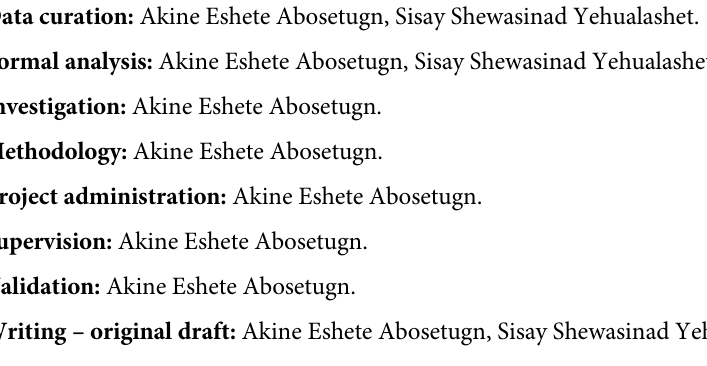
S1 Table. JBI critical appraisal checklist for studies reporting prevalence